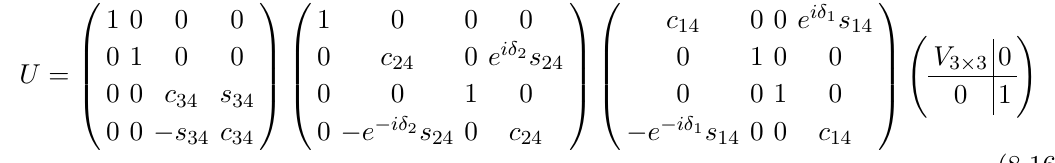
Figure 5 . Correlations among di(cid:11)erent elements of j X d (blue) using the angles (8.19). In black we show the points excluded from R b and CP violation in the kaon sistem; cf. (8.14) and